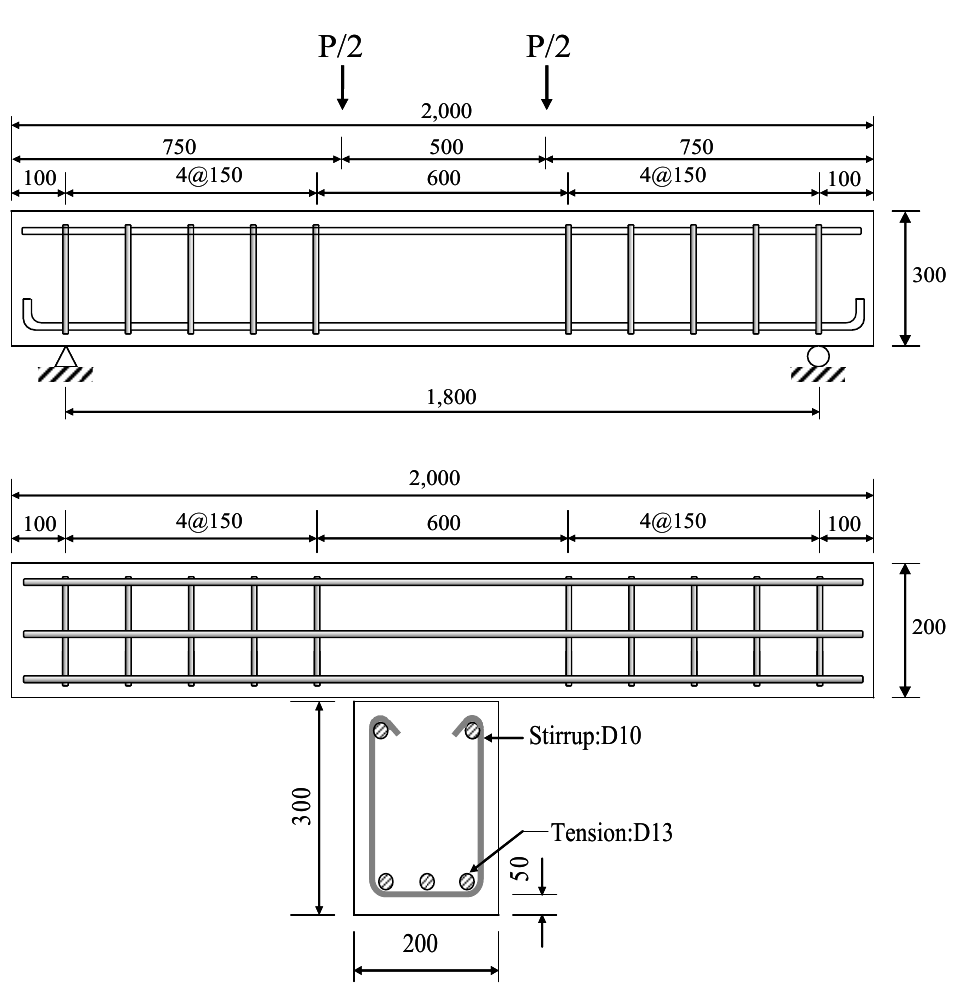
Figure 6. Dimensions and details of RC beams (units: mm).